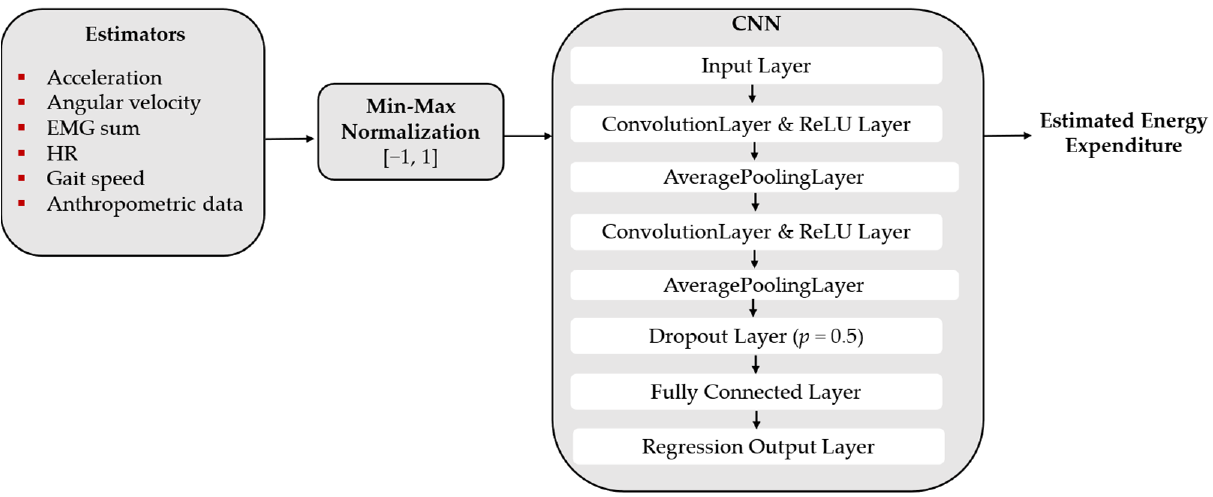
Figure 4. CNN’s architecture of the final model.